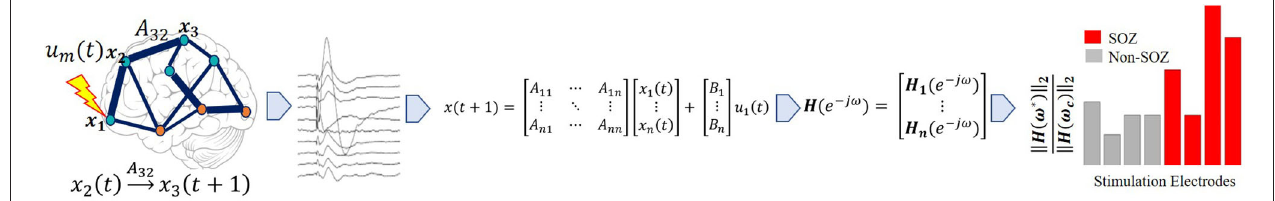
FIGURE 3 | Pipeline to obtain system gain H ∞ - to- input norm ratio from individual patients’ SPES iEEG data. Starting from top left, a brain region is stimulated. Then a stereotyped response is extracted for each electrode, from which the average evoked CCEP is calculated. The CCEPs are used to construct a state-space model. From the state space model, a SIMO transfer function vector is constructed via H ( z ) = C ( zI − A ) − 1 B . Then the maximum system gain is calculated for every stimulation pair through k H ( ω ) k ∞ = sup ω ǫ R σ max ( H ( e − i ω ) ) and the 2-norm of the associated frequency response at the cutoff frequency, is computed resulting in the PF ratio. The expectation is that the true SOZ contacts will have the largest PF